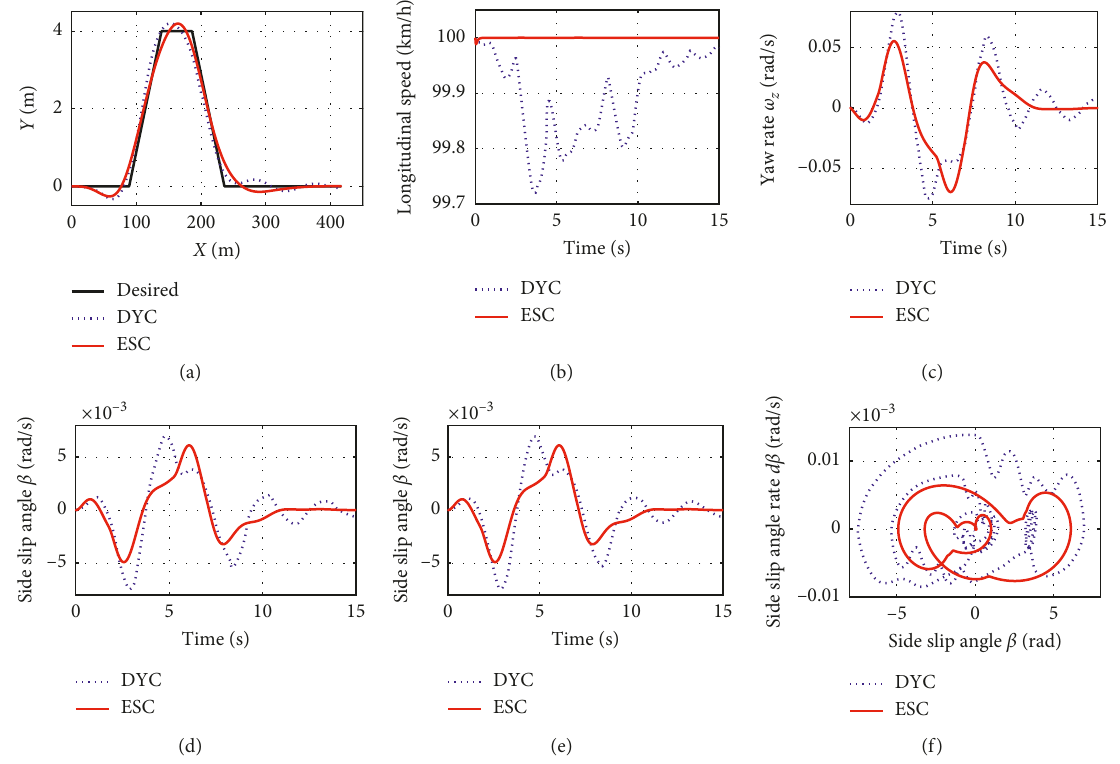
Figure 17: HIL simulation results: (a) trajectory; (b) longitudinal speed; (c) yaw rate; (d) side slip angle; (e) side slip angle change rate; (f) side slip angle and its